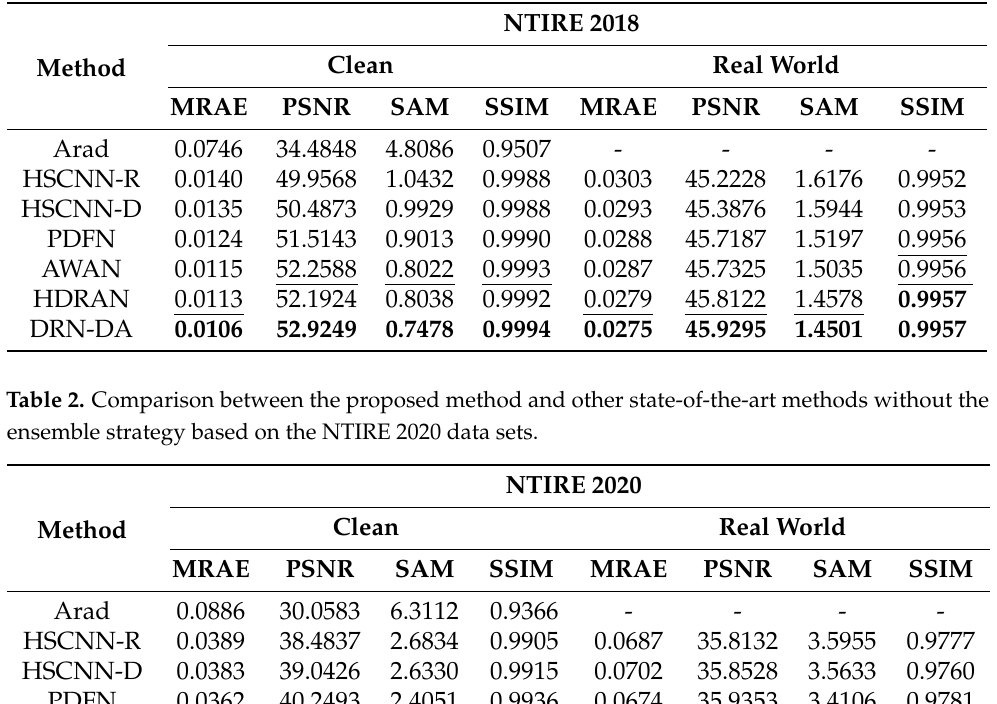
Table 1. Comparison between the proposed method and other state-of-the-art methods without the ensemble strategy based on the NTIRE 2018 data sets.